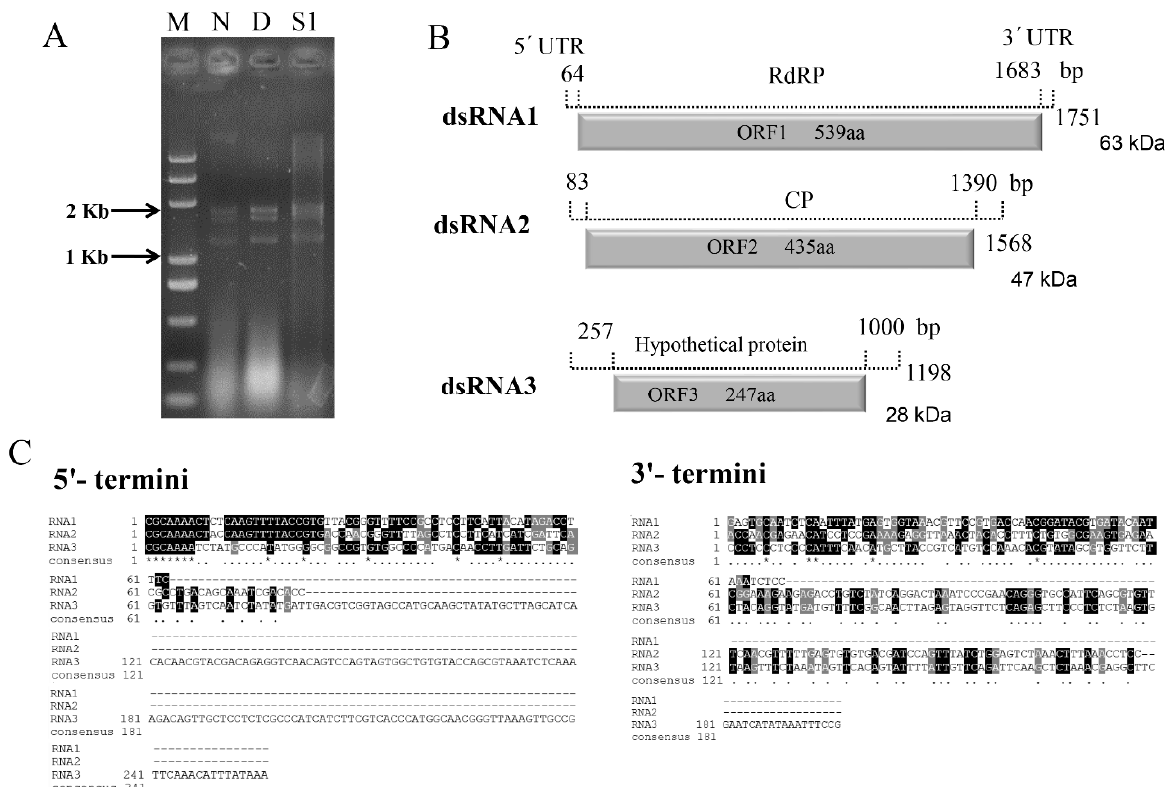
Figure 1. Genomic organization of BdPV2. ( A ) Lane M, DL5000 DNA marker; Lane N, dsRNA extracted from strain ZM170285-1; Lanes D and S1, dsRNA was treated with DNase I and S1 nuclease. ( B ) Schematic representation of genomic organization of BdPV2. ( C ) Multiple sequence alignment of 5´- and 3´-UTRs of BdPV2. *, conserved amino acid residues. Table 1. Information of BLASTp search results of Botryosphaeria dothidea partitivirus 2 (BdPV2) .